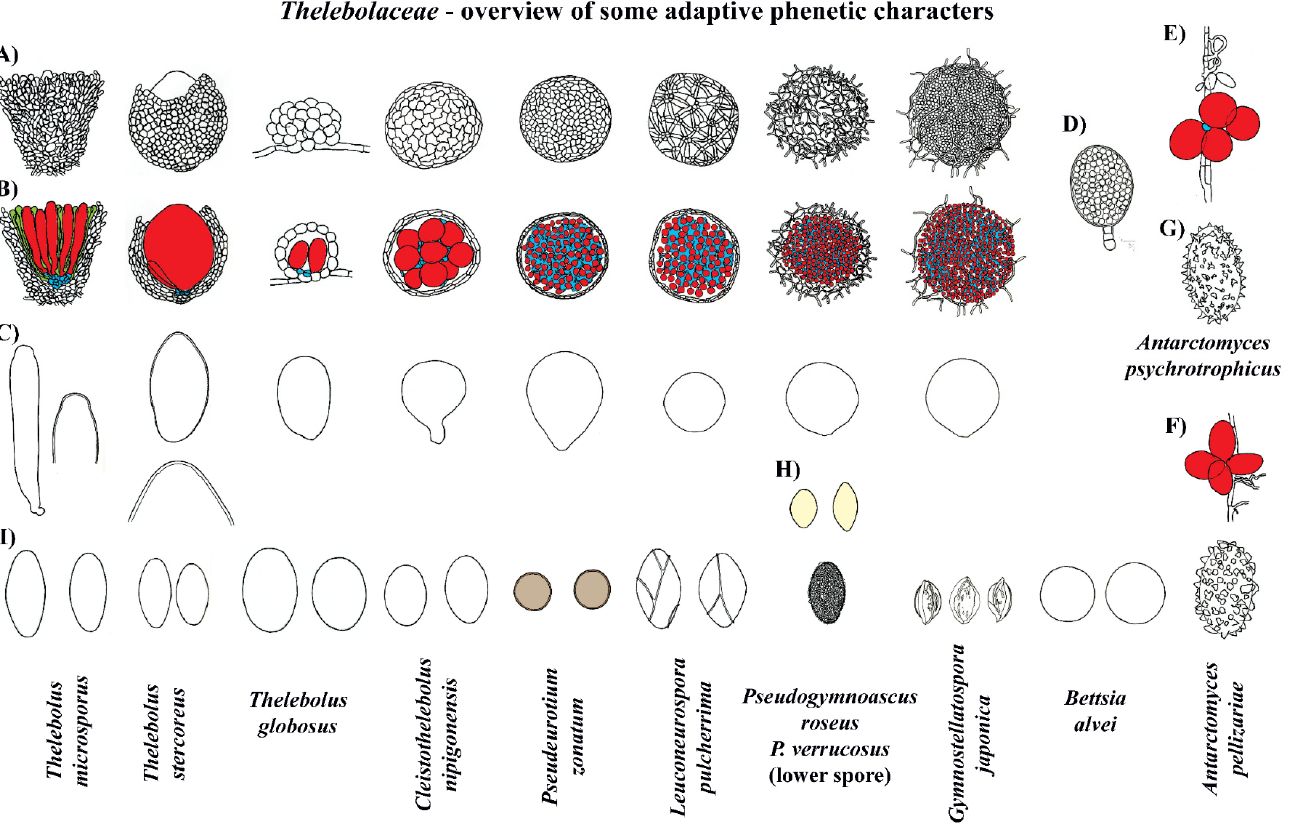
Figure 7. Thelebolaceae -an overview of some adaptive phenotypic characters. ( A ) Ascomata-side view. ( B ) Ascomata in section. ( C ) Asci (in Thelebolus microsporus and T. stercoreus, also enlarged view of ascus tips). ( D ) Cyst-like ascoma with ascospores inside. ( E , F ) Naked asci. ( G , H , I ) Ascospores. Color code: Red = asci; blue = ascogenous cells; green = hamathecium. Compiled drawings are not presented to scale in order to fit the single plate. Del. N. Mato č ec.